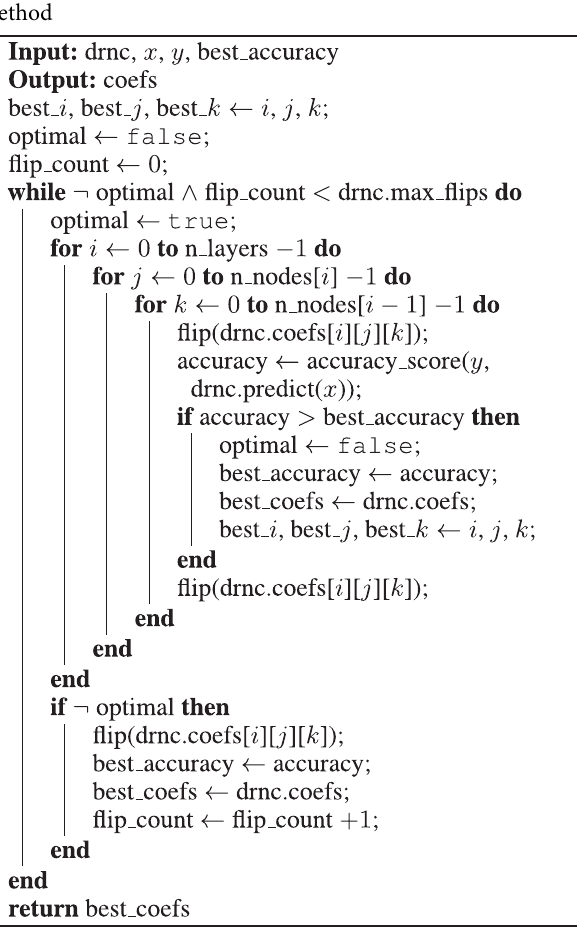
Frontiers in Arti fi cial Intelligence |